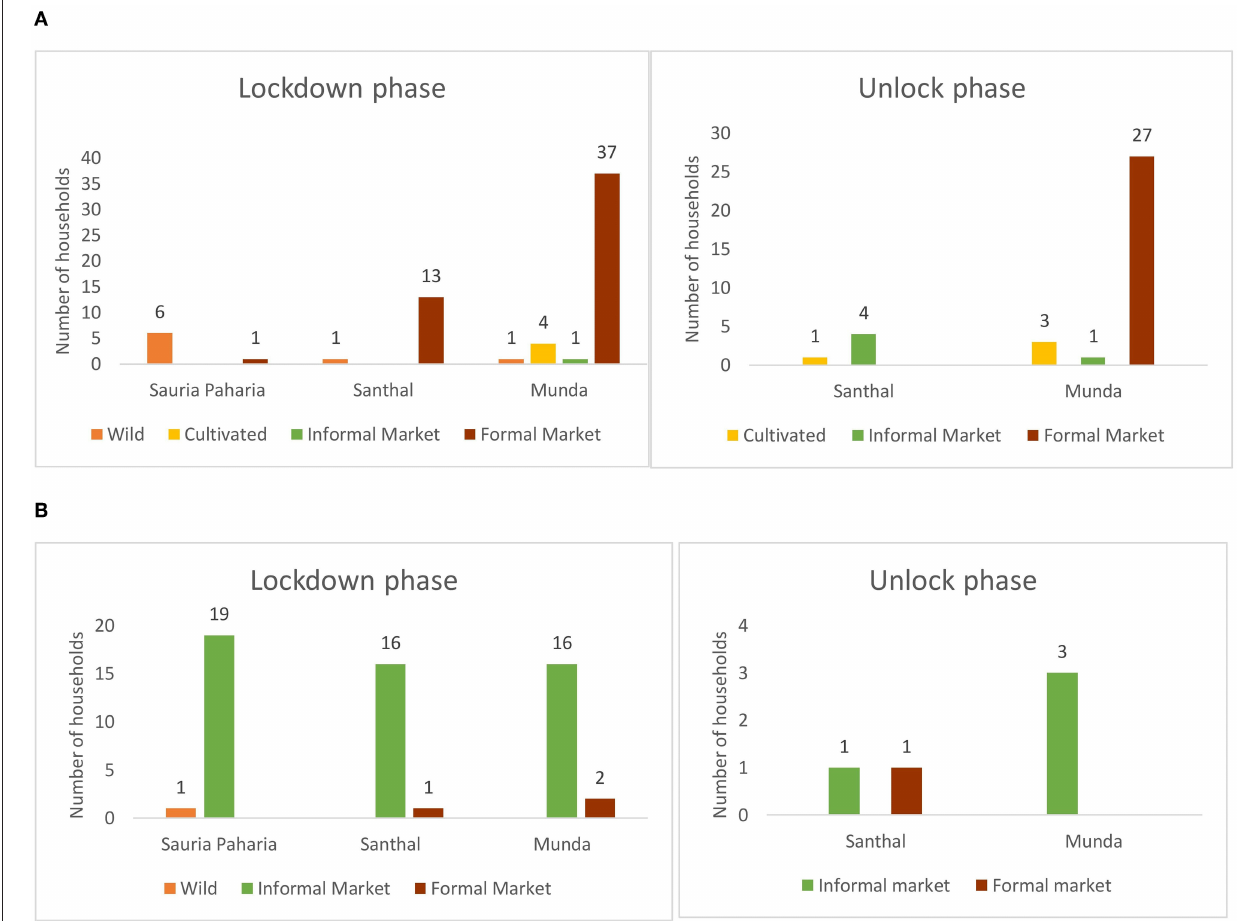
FIGURE 6 | Impact of COVID-19 pandemic on household food access in indigenous communities of Jharkhand, India. (A) Number of HHs citing places that were easier to access for food during the lockdown phase (May-June, 2020) and the unlock phase (September-October, 2020). (B) Number of HHs citing places that were difficult to access for food during the lockdown phase (May-June, 2020) and the unlock phase (September-October, 2020).